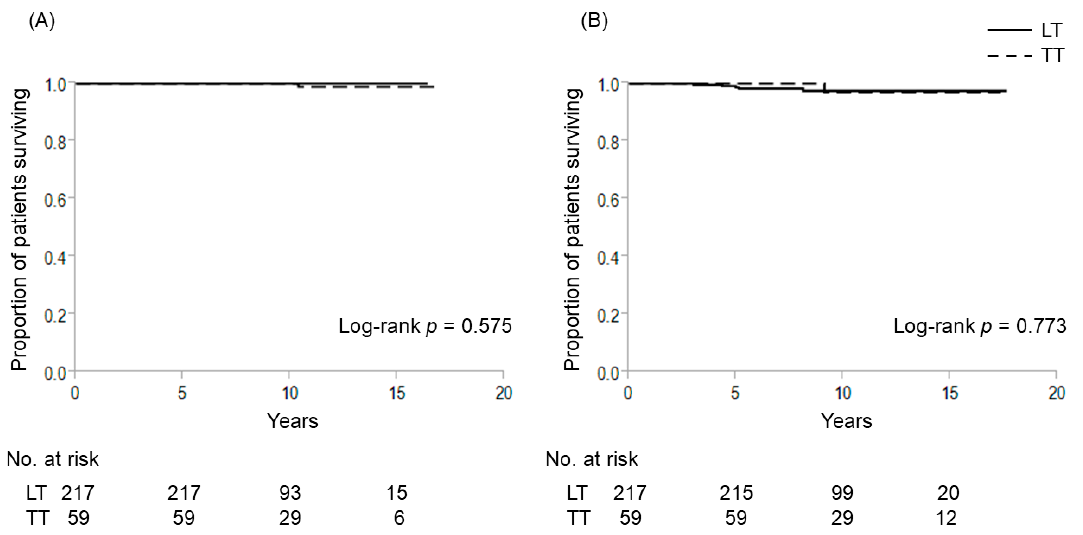
Figure 4. Cause-specific and disease-free survival curves for patients without TERT promoter mutations who underwent lobectomy and total thyroidectomy for patients with intrathyroidal PTC with a maximal diameter of 1–4 cm. ( A ) Cause-specific survival; ( B ) disease-free survival. LT, lobectomy; TT, total thyroidectomy.